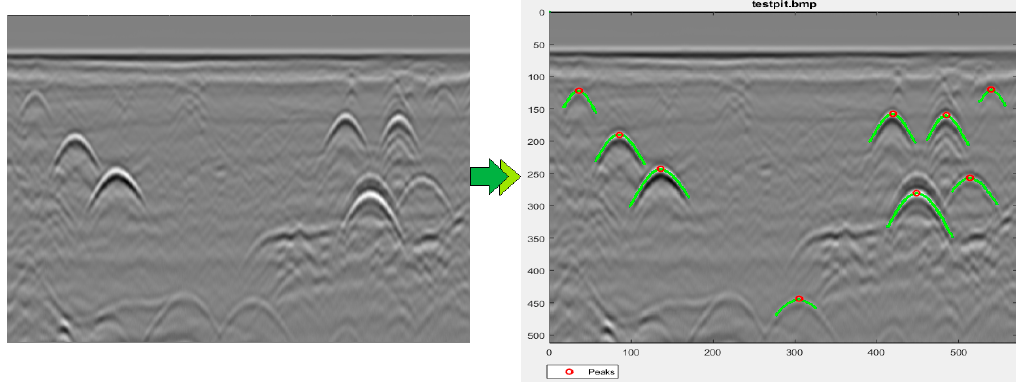
Figure 9 . Raw and processed radargram. Figure 9. Raw and processed